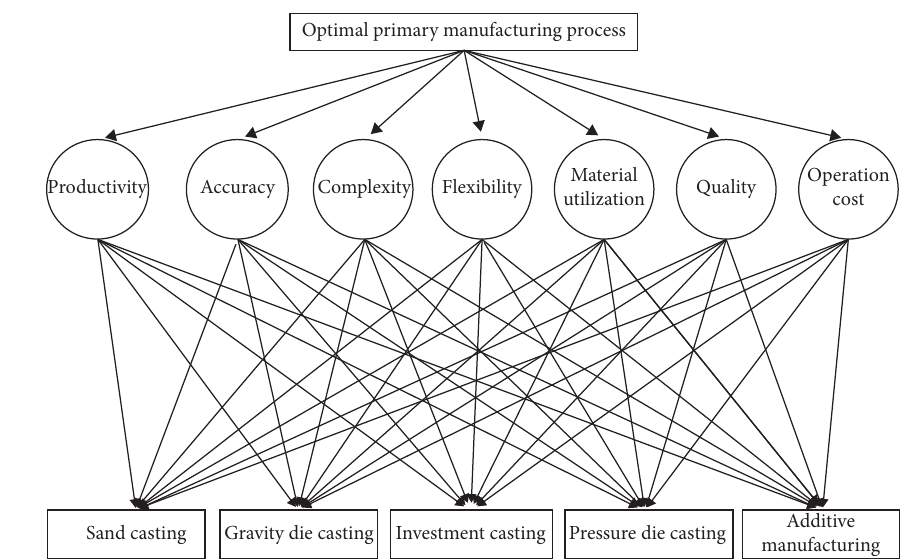
Figure 3: Attributes used for the manufacturing process evaluation. Table 2: The main criteria evaluation